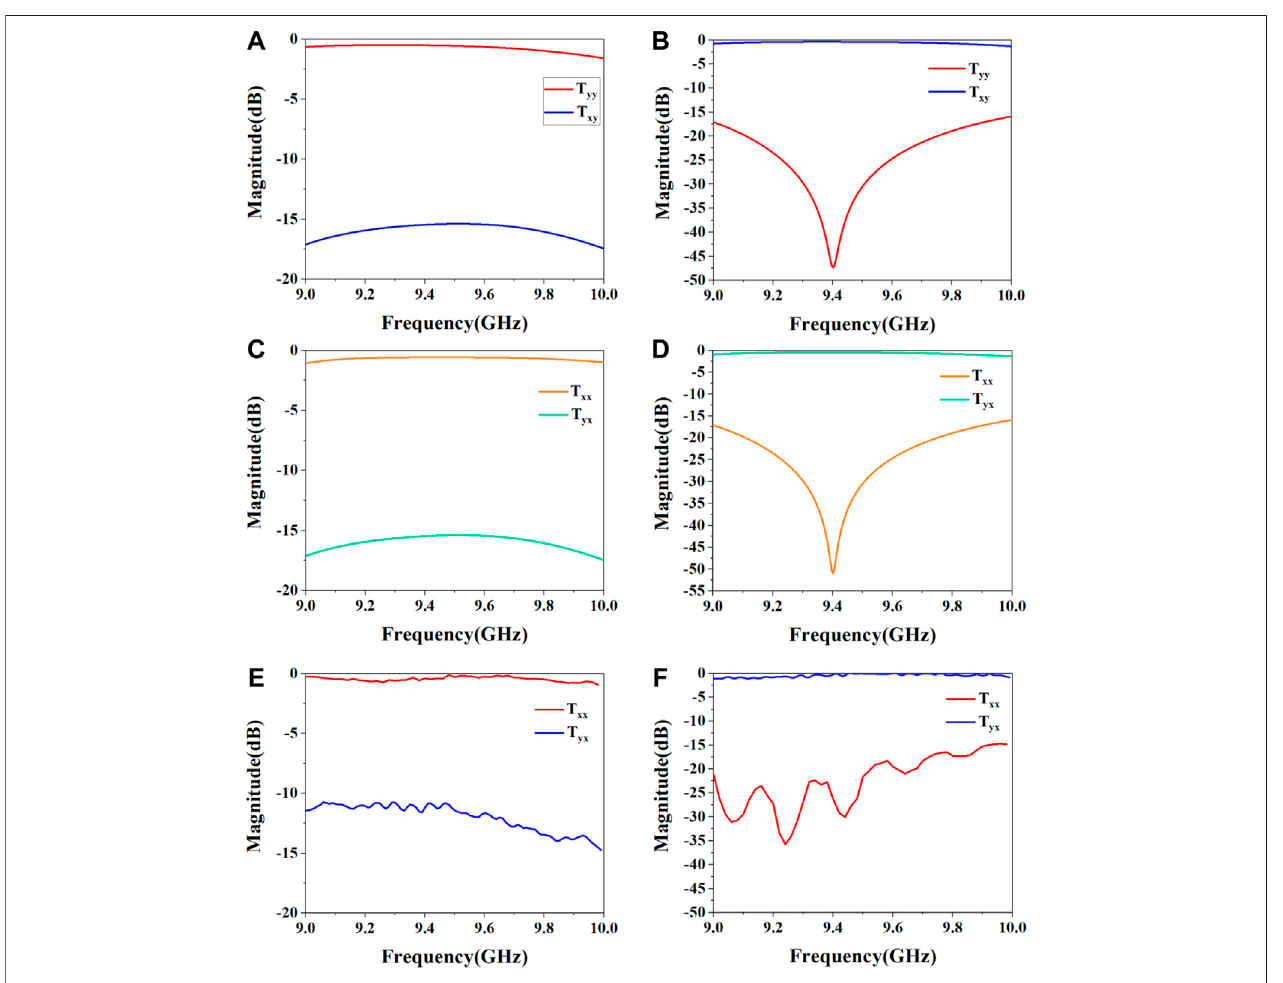
FIGURE 4 | (A,B) are the results when the initial emission is a y-polarized wave; (C,D) are the results when the initial emission is an x-polarized wave. (E,F) are the measurementresultswhentheinitialemissionisanx-polarizedwave. (A) Theco-polarizedtransmissivity(T yy )andthecross-polarizedtransmissivity(T xy )withoutrotating the DPM. (B) The co-polarized transmissivity (T yy ) and the cr-polarized transmissivity (T xy ) with the DPM rotating 45 ° . (C) The co-polarized transmissivity (T xx ) and the cr- polarized transmissivity (T yx ) without rotating the DPM. (D) The co-polarized transmissivity (T xx ) and the cr-polarized transmissivity (T yx ) with the DPM rotating 45 ° . (E) The co-polarized transmissivity (T xx ) and the cr-polarized transmissivity (T yx ) without rotating the DPM. (F) The co-polarized transmissivity (T xx ) and the cr-polarized transmissivity (T yx ) with the DPM rotating 45 °